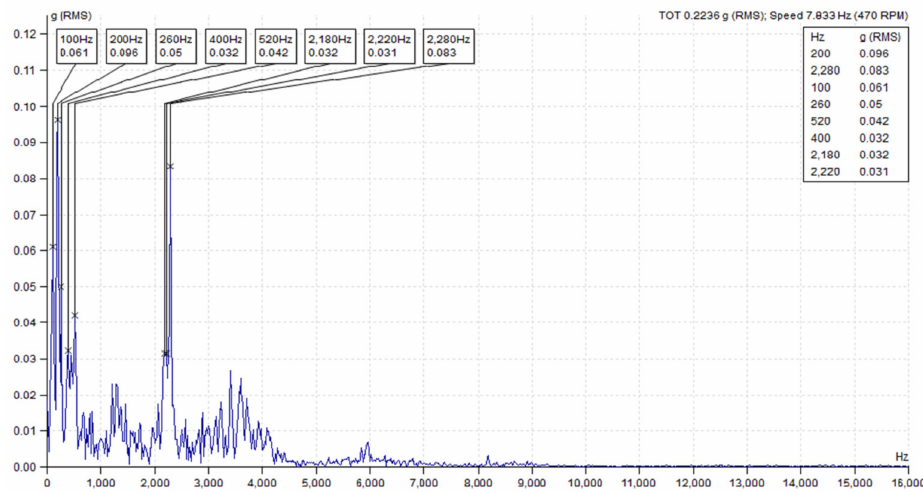
Figure 15. Top 8 peaks from overall spectrum (10 Hz–16 kHz) of Massey Ferguson Beta.